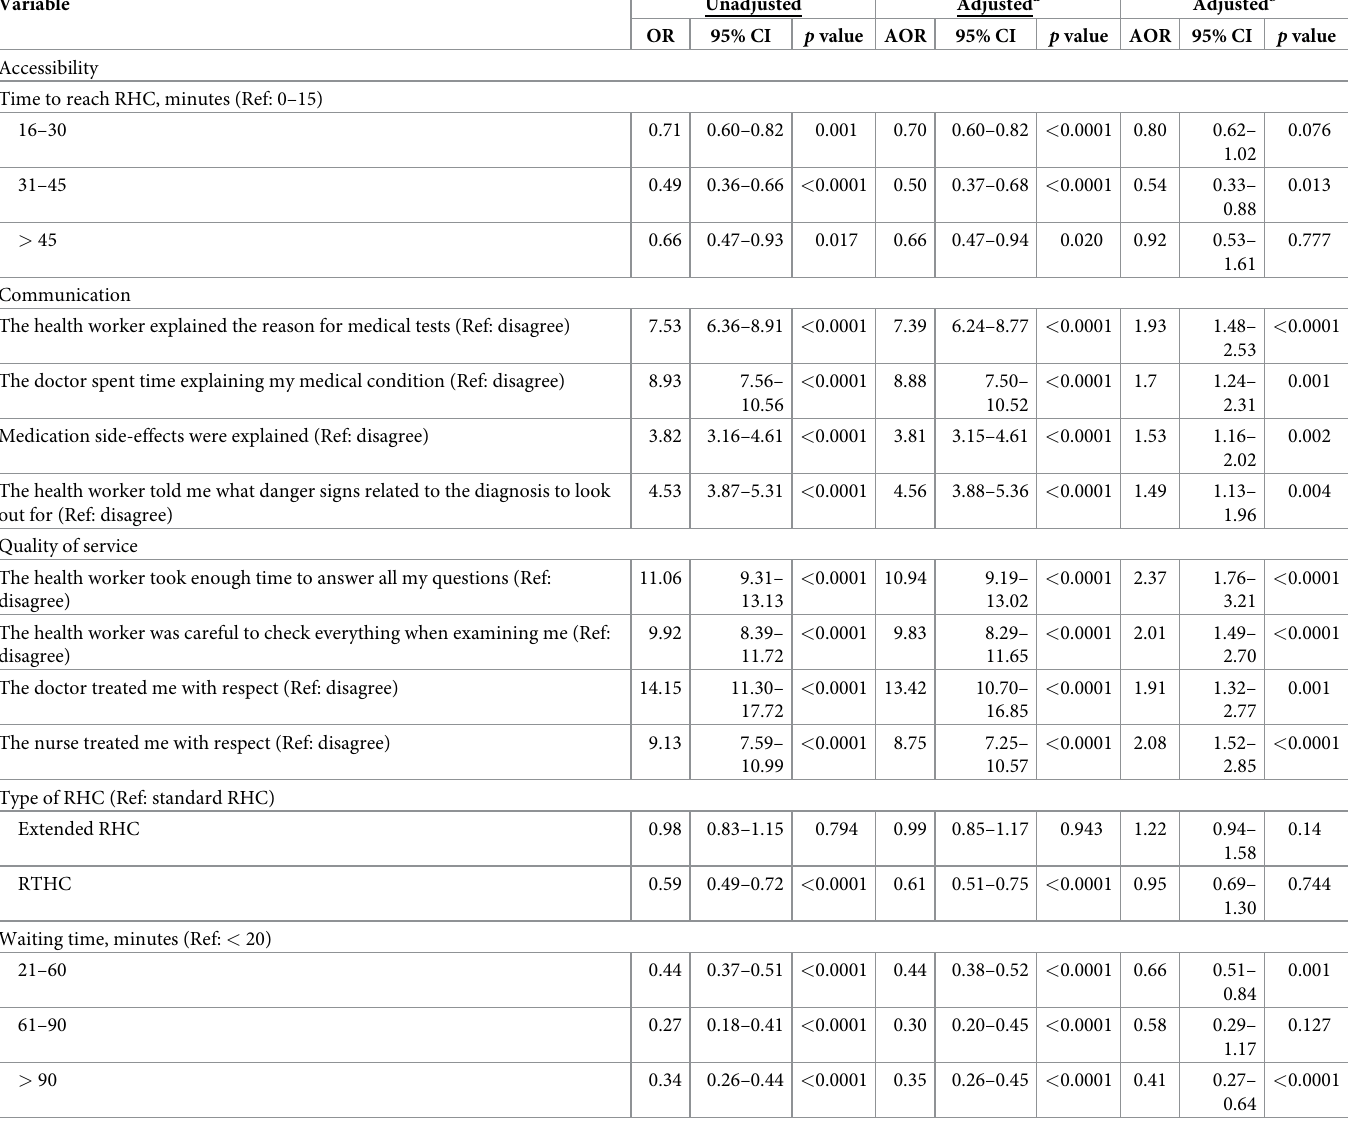
Table 4. Multiple logistic regression analysis of RHC characteristics that might influence patient